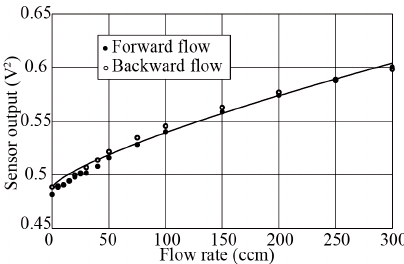
Figure 5. Relationship between flow rate and sensor output.